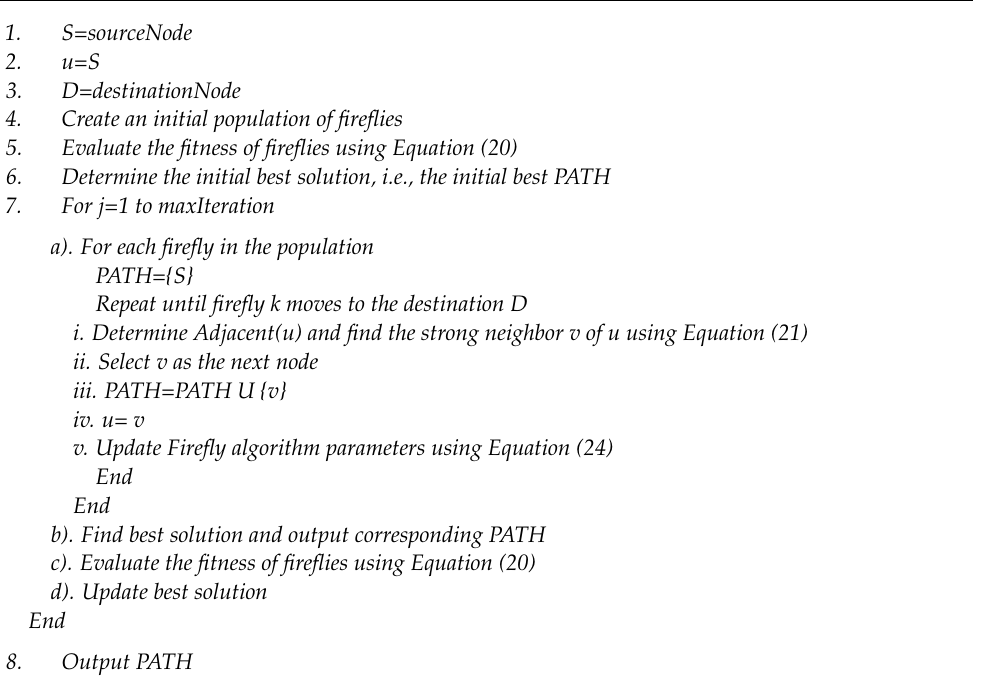
Algorithm 7 : Energy-efficient path